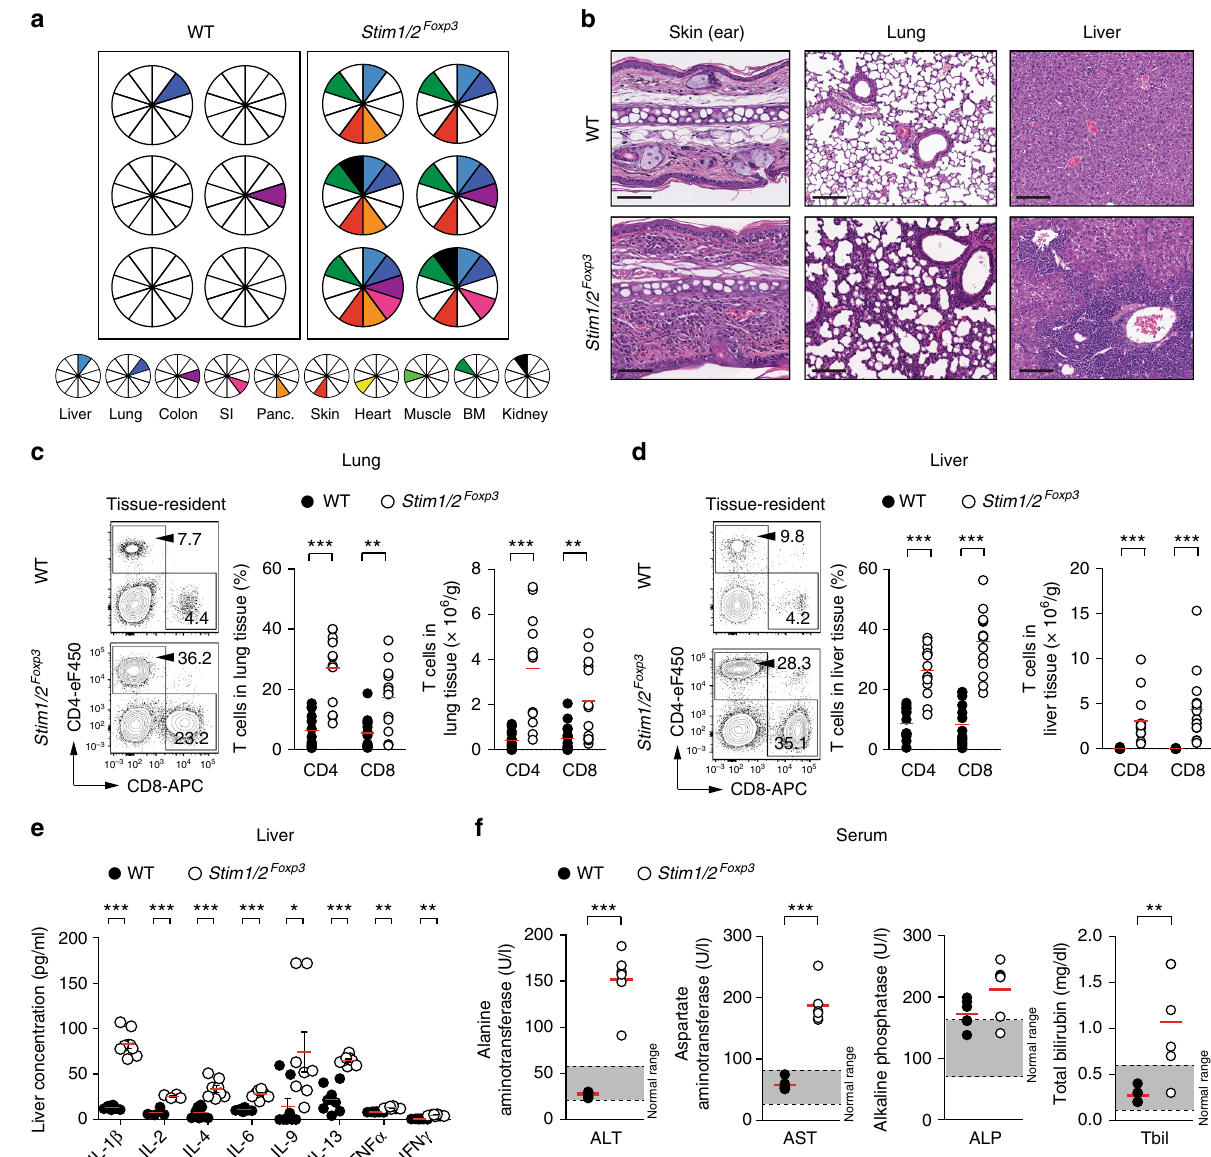
Fig. 5 Deletion of Stim1 and Stim2 genes in Treg cells causes severe tissue in fl ammation. a , b Leukocytic in fi ltration and signs of tissue in fl ammation in various non-lymphoid organs of male WT and Stim1/2 Foxp3 mice by histopathology. a Each pie chart represents the analysis of one mouse. b Representative examples of H&E-stained tissue sections of skin, lung, and liver; scale bars represent 150 µ m. c , d Analysis of tissue-resident CD4 + and CD8 + T cells in the lung ( c ) and liver ( d ) of male WT and Stim1/2 Foxp3 mice by fl ow cytometry; means of 12 – 15 mice. See Supplementary Figure 7 h, i for the gating strategy of tissue-resident T cells. e Detection of cytokines in total liver homogenates of male WT and Stim1/2 Foxp3 mice; means ± SEM of 4 – 8 mice. f Analysis of alanine aminotransferase (ALT), aspartate aminotransferase (AST), alkaline phosphatase (ALP), and total bilirubin (Tbil) concentrations in the sera of male WT and Stim1/2 Foxp3 mice by clinical chemistry; means of six mice. Each dot in c , d , and f represents one mouse. Statistical analysis in c – f by unpaired Student ’ s t -test. * p < 0.05; ** p < 0.01; *** p <